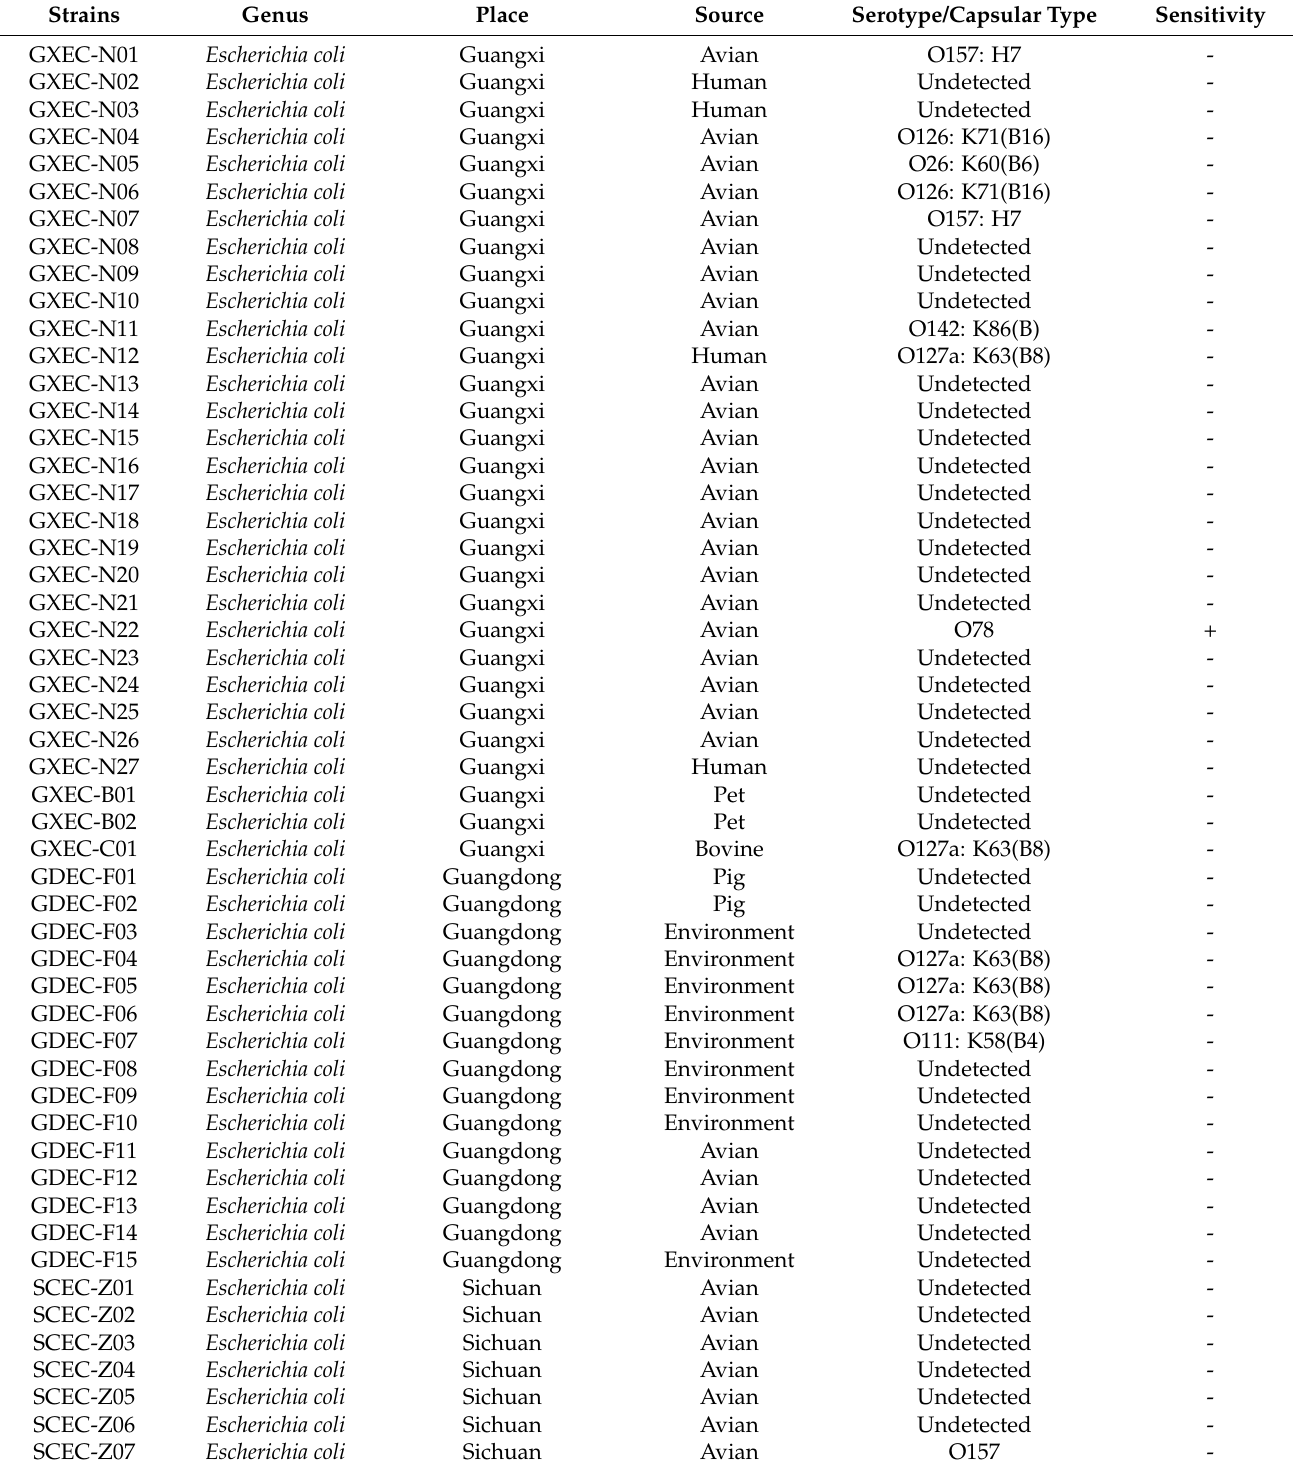
Table 1. Bacterial strains